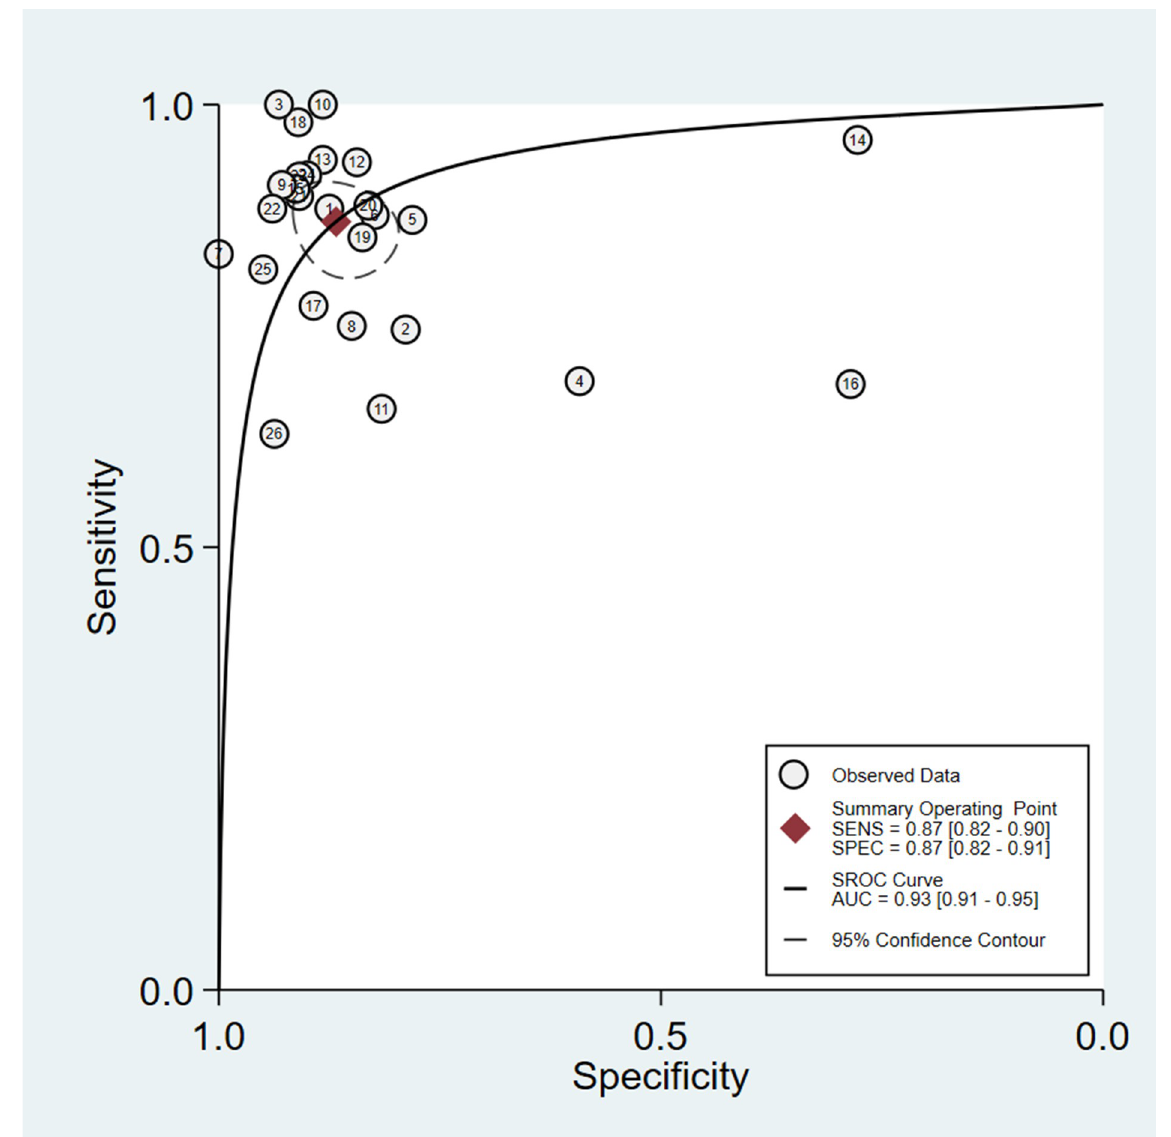
Fig 6. SROC curve for AI-assisted diagnosis of lung cancer.